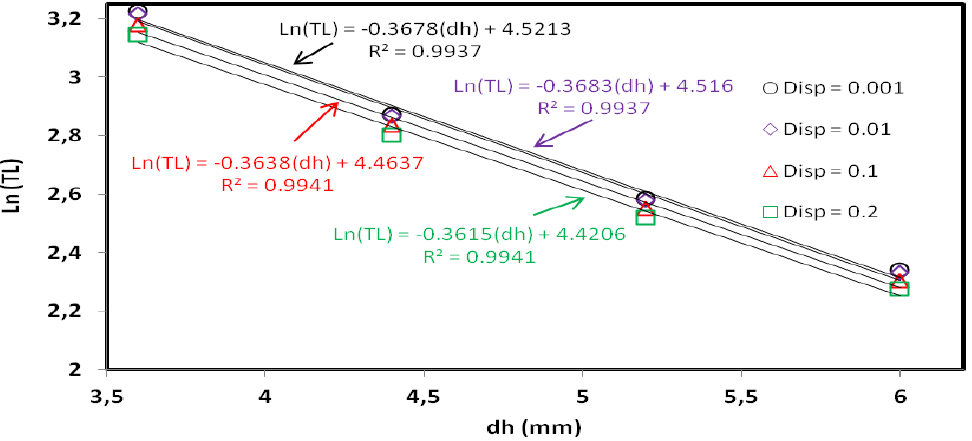
Figure 11. Change of the logarithmic toe length with the head difference for different dispersivity values over the range 0.001–0.2 cm.